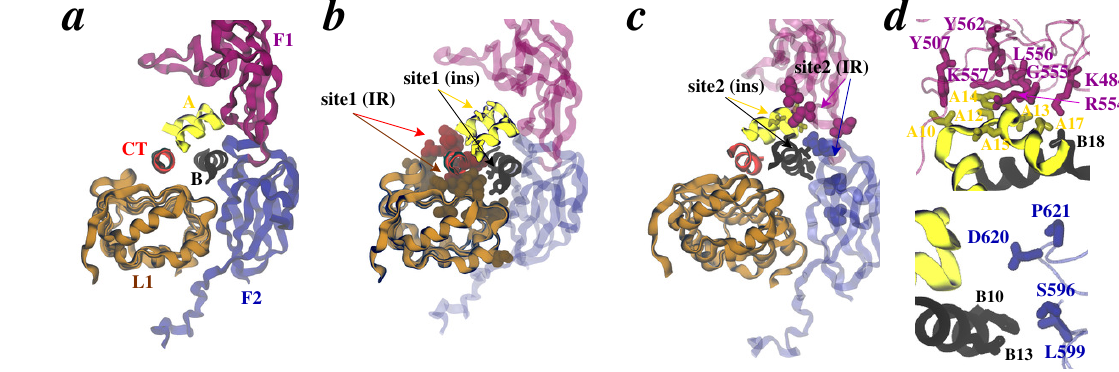
Figure 5. MDFF-generated model of insulin/IR ∆ β . ( a ) Final placement of insulin/ α CT is shown in the MDFF-generated model of hormone/receptor complex. The hormone/receptor chains/domains are uniquely colored and labeled. Other domains of IR ∆ β are omitted for clarity. ( b,c ) Interacting residues at Site 1 and Site 2 of hormone (ins) and receptor (IR) are highlighted. Contacts at Site 1 are consistent with crystal structures [58], and no steric clash is present with suggested Site 2 residues [4,40] located in loops of the F1 and F2 domains. ( d ) Residue-residue contacts between insulin and IR at Site 2 are